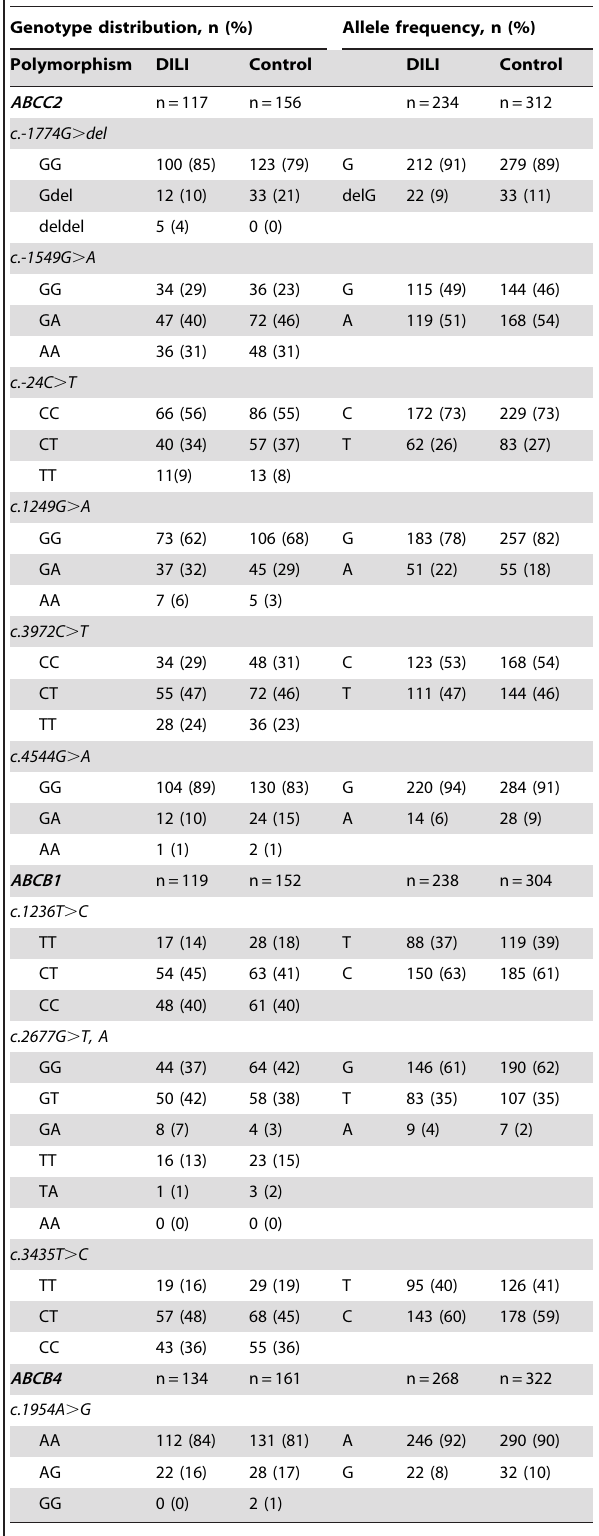
Genotype distribution, n (%)